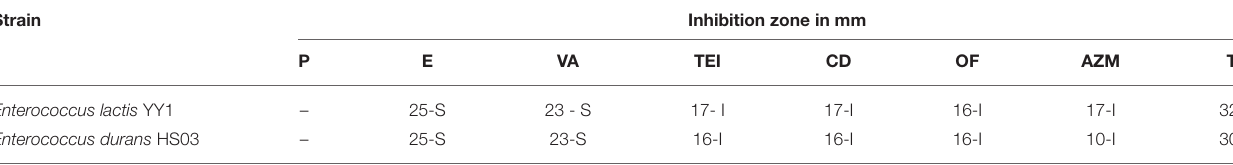
TABLE 5 | Antibiotic sensitivity test.